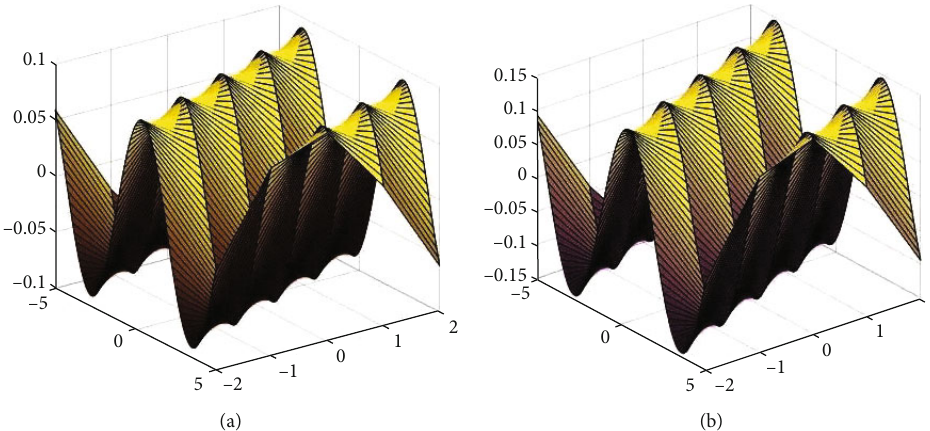
Figure 2: The di ff erent fractional-order result of μ ð χ , ξ , I Þ at δ = (a) 0 : 8 and (b) 0.6 of example.